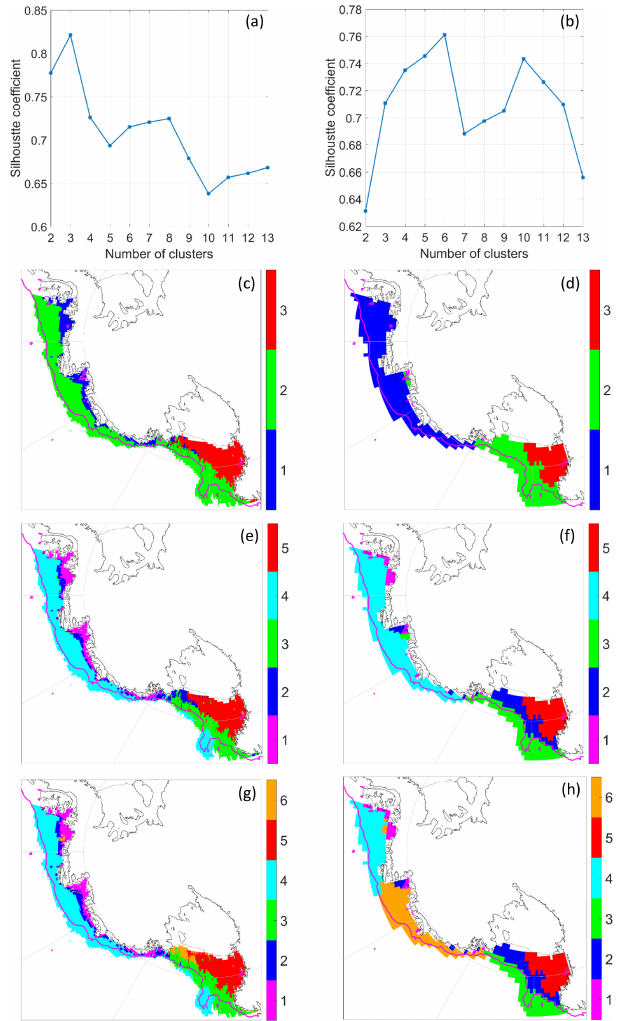
Figure 3. K -means clustering evaluation for WOA and CESM. Silhouette analysis is shown in (a) and (b) for WOA and CESM, respectively. The geographic regions corresponding to 3, 5 and 6 groups for WOA, (shown in c , e and g ) and for CESM (shown in d , f and h ) are shown.